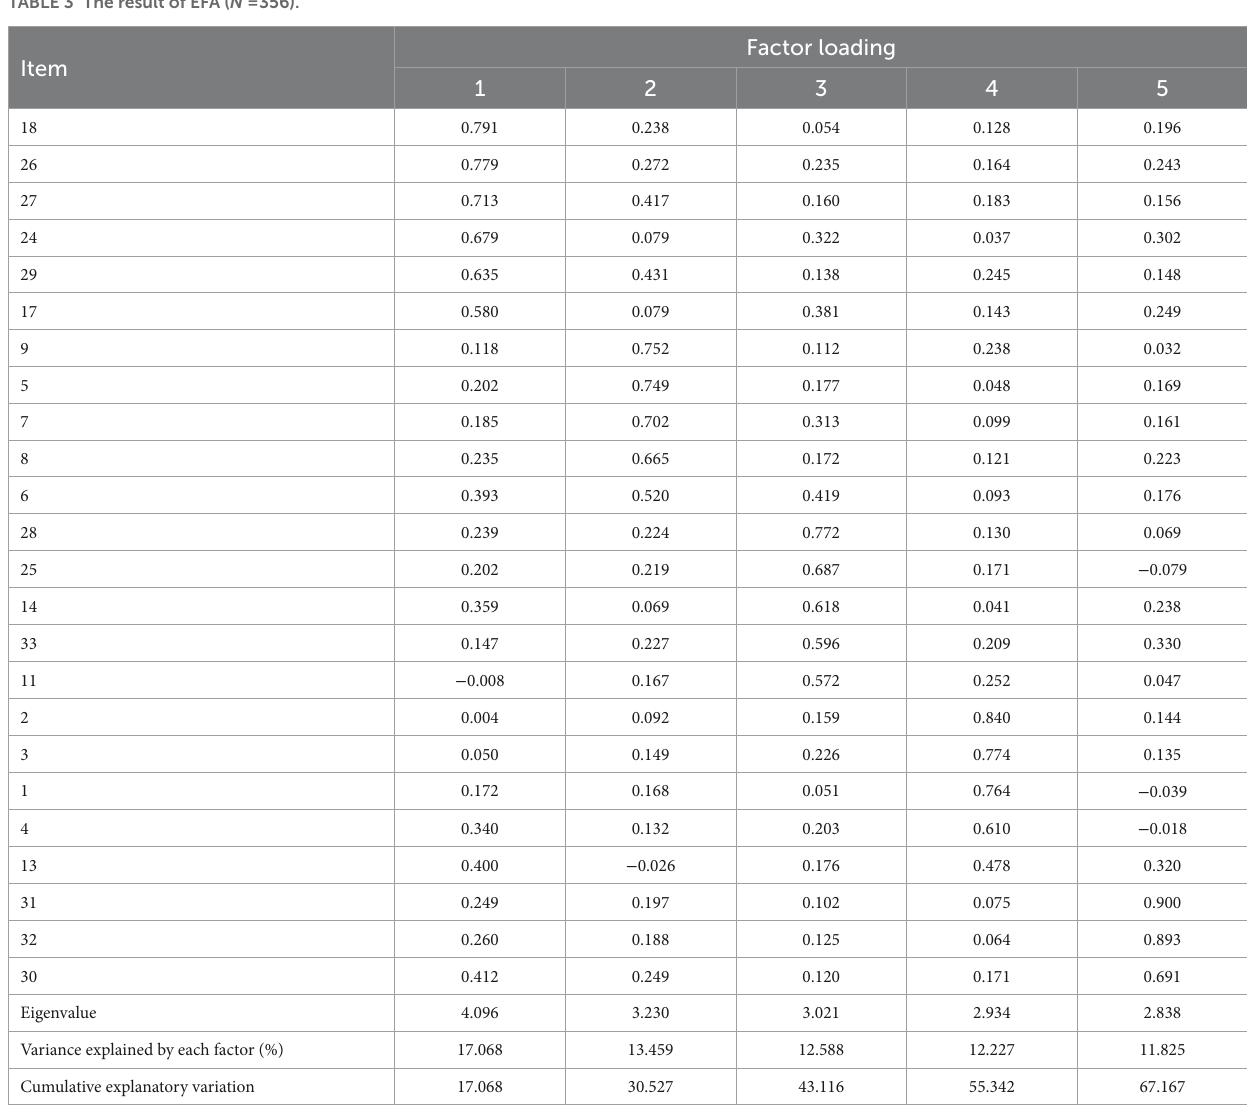
TABLE 3 The result of EFA ( N =